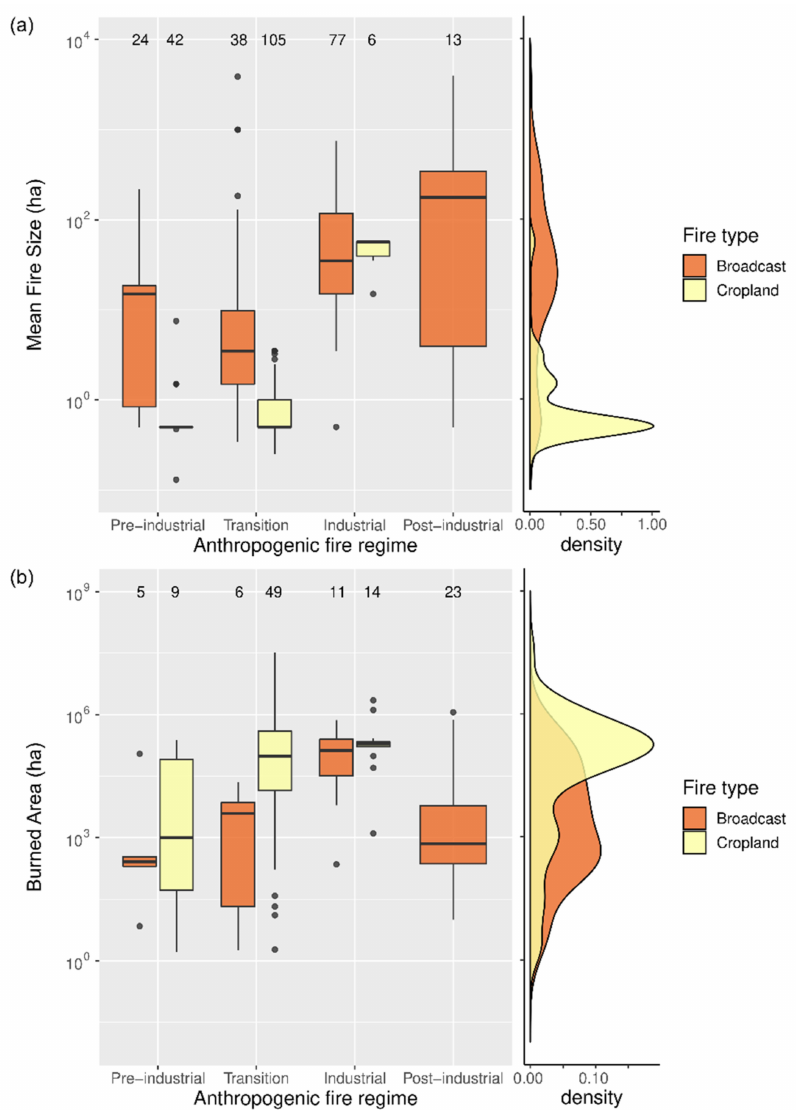
Figure 3. Distributions of ( a ) fire size and ( b ) burned area in DAFI. Data are grouped by Anthro- pogenic Fire Regime (box plots) and combined in kernel density estimates. Fires are also grouped by fire use; cropland fires are ‘field preparation’ and ‘crop residue burning’ uses, with broadcast fires composed of all other uses. Cropland fires are smaller (mode < 1 ha) yet can contribute to larger burned areas than broadcast